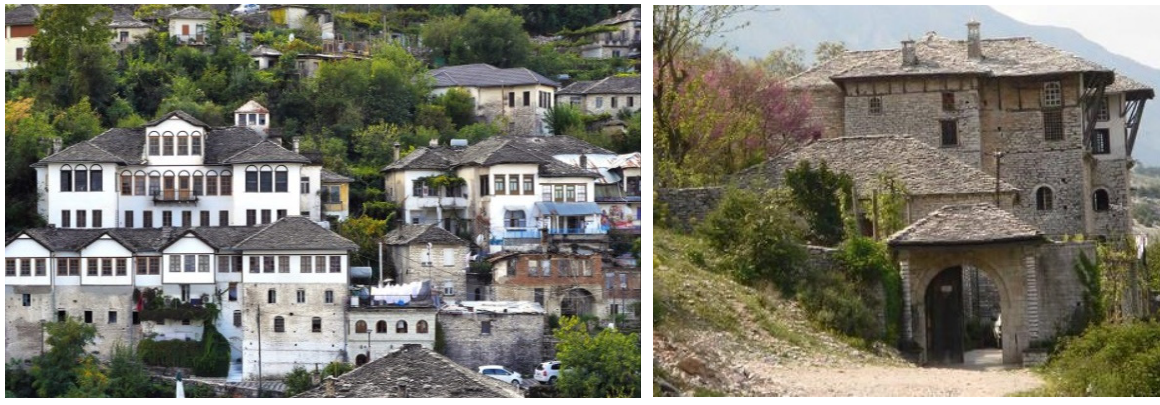
Figure 2. Typical historic masonry constructions of Gjirokastër.